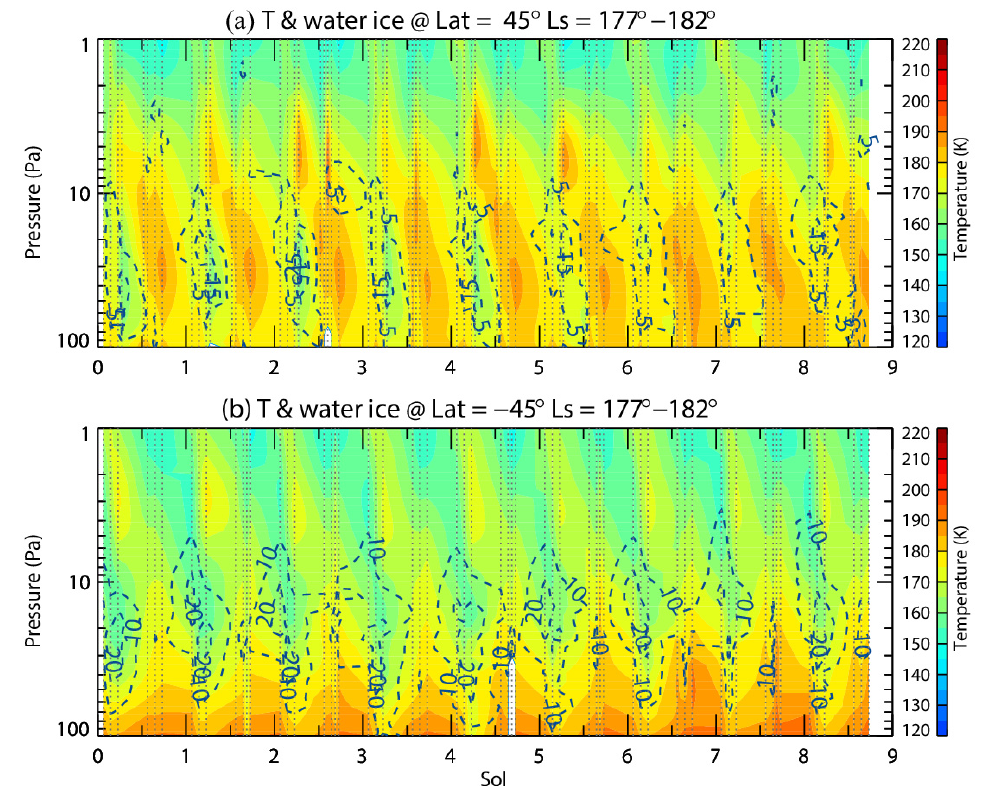
Figure 4. An example of 8-sol time evolutions of the zonal mean temperature (color shading) and water ice opacity (dashed contours) at ( a ) the northern and ( b ) southern middle latitudes during the northern fall equinox. All data are obtained by the MCS cross-track observational strategy to increase the local time coverage (Figure 1). The vertical grey dotted lines indicate the data sampling local time. The 0 a.m. of each sol corresponds to the marking place of the x coordinate value. Note that the water opacity value has been multiplied by 10 4